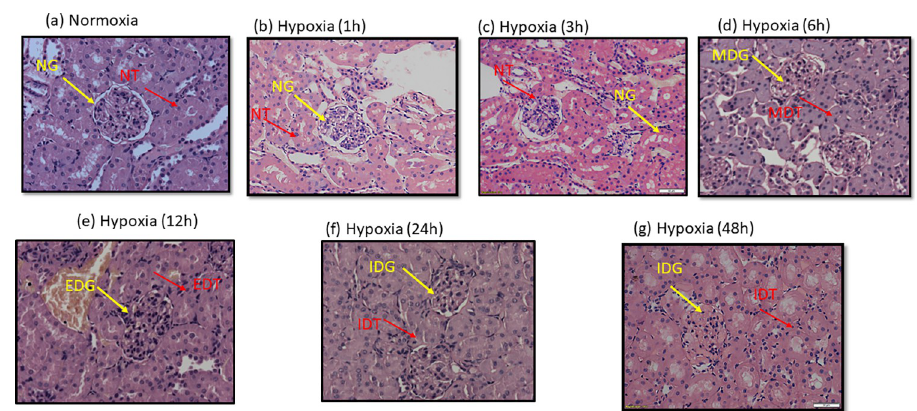
Fig 5. Histopathological images representing the degeneration of renal tubules, glomerulus and Bowman’s capsule, swelling of renal tubules in rats exposed to hypobaric hypoxia for different time durations (0h, 1h, 3h, 6h, 12h, 24h and 48h) at 7620 m (25,000 ft.), 25 ± 2˚C (a) Photomicrograph (20X) section of kidney from normoxia control group representing intact normal glomerulus (NG) and Bowman’s capsule with normal tubules (NT) structure without fluid accumulation (b) Photomicrograph (20X) section of kidney from 1h hypobaric hypoxia exposed rats showed unmodified kidney conformation of NG and NT (c) Photomicrograph (20X) section of kidney from group exposed to hypobaric hypoxia (3h) exhibited no difference in kidney configuration with NG and NT (d) Photomicrograph (20X) section of kidney from hypobaric hypoxia exposure for 6h, revealed mild degeneration of glomerulus and Bowman’s capsule (MDG), Mild degeneration of renal tubules (MDT) with mild hypertrophy followed by ballooning of tubular epithelial cells (e) Kidney sections (20X) of hypobaric hypoxia exposed animals for 12h duration had demonstrated the increased tubular cell ballooning, excessive degeneration of glomerulus (EDG), swelling of renal tubules, mesangial proliferation, with large spaces in between the Bowman’s capsular glomeruli along with congested vessels. (f) Photomicrograph (20X) section of kidney from 24h hypobaric hypoxia exposed group manifested the increased degeneration of glomerulus (IDG), increased degeneration of renal tubules (IRT) and (g) a (20X) photomicrograph section of kidney from 24h of hypobaric hypoxia exposed group demonstrated the IDG and IDT. NG : Normal glomerulus and Bowman’s capsule, NT : Normal renal tubules, MDG: Mild degeneration of glomerulus and Bowman’s capsule, MDT: Mild degeneration of renal tubules, EDG: Excessive degeneration of glomerulus and Bowman’s capsule, EDT: Excessive degeneration and swelling in renal tubules IDG: Increased degeneration of glomerulus, IDT: Increased degeneration of renal